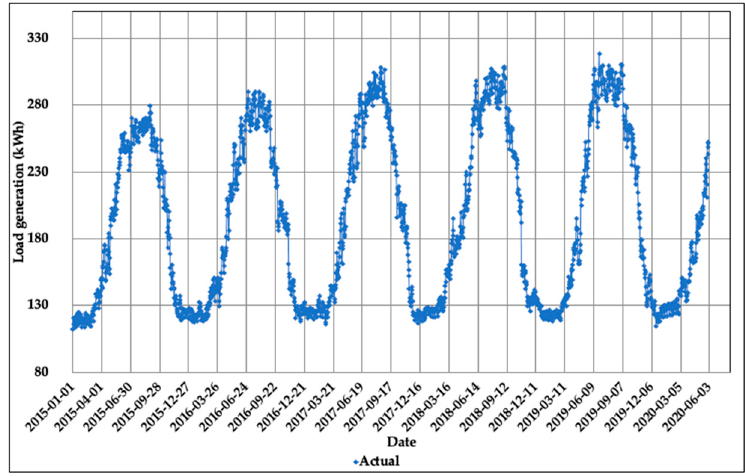
Figure 1. The actual data of generated daily loads data in Kuwait between January 2015–May 2020.